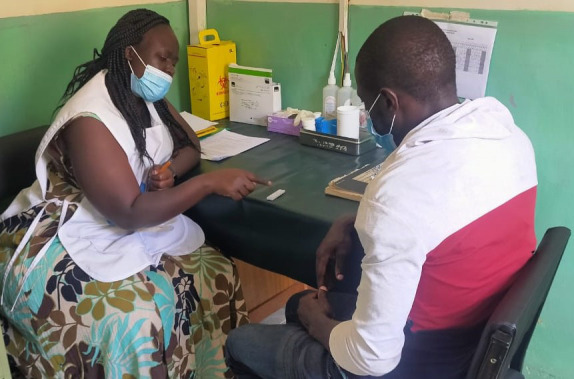
Photo: Kisumu community counsellor discussing COVID RDT result with client (from Emmanuel Milimo’s own collection, used with permission).